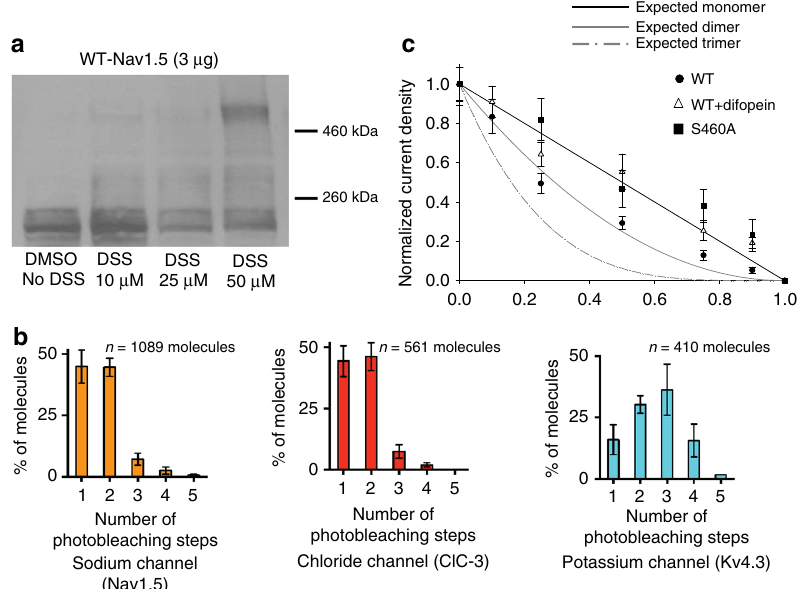
Fig. 1 Na v 1.5 α -subunits form a dimer: a Crosslinking experiments performed with DSS in HEK293 cells expressing Nav1.5. Crosslinking was performed using DSS at different concentrations for 20 min. A band corresponding to a dimer of Na v 1.5 α -subunit is observed in presence of the crosslinker at higher concentrations compared to the cells where no crosslinking was performed (left DMSO no DSS). Full blots are presented in Supplementary Fig. 12. b GFP photobleaching steps observed through SiMPull experiments for sodium channel GFP-Na v 1.5, the chloride channel ClC-3-GFP known to form dimers, and the potassium channel Kv4.3-GFP known to form tetramers. The number of molecules analyzed ( n ) for each channel is indicated above each graph.